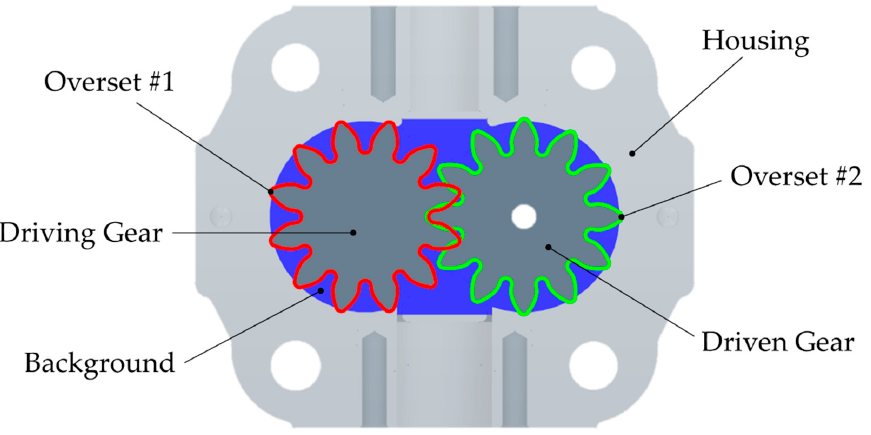
Figure 4. Overset approach in the gears’ domain.